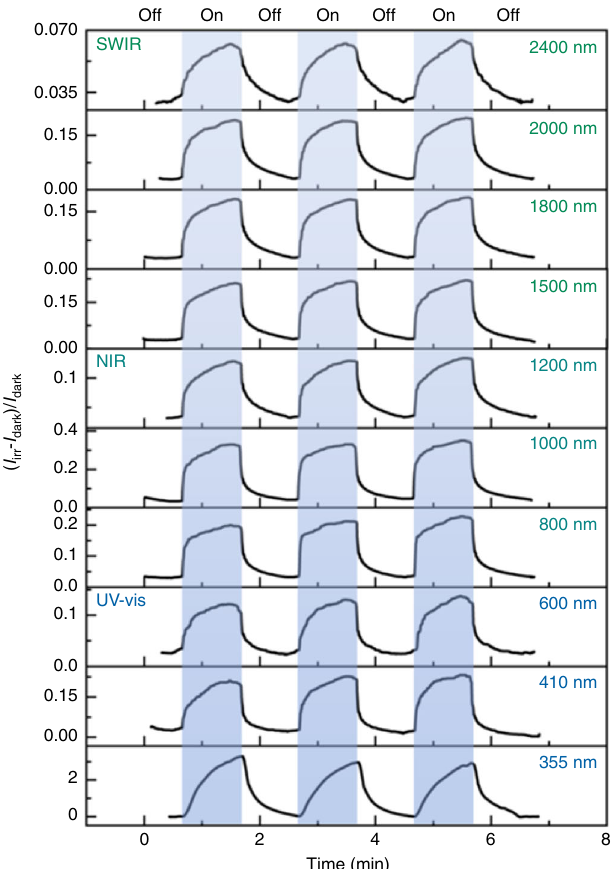
Fig. 5 Photoresponse behavior of 1B-T monitored using lasers with different wavelengths. A Newport Co. Pulseo GKNQL-355-3-30 diode pumped solid-state laser (70 kHz, 39 ns pulse width) and an OPO laser (10 Hz, 10 ns pulse width) are used for 355 nm and 410 – 2400 nm light, respectively. Powers for each wavelength: 355 nm, 2.1 W; 410 nm, 7.5